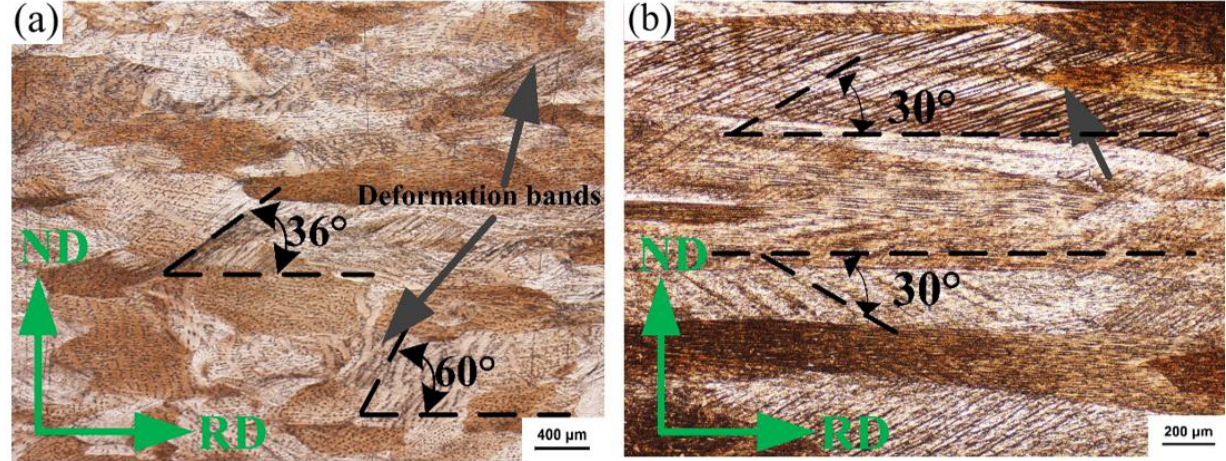
Figure 7. Metallography of longitudinal section of cold rolled strip (ε = 50%). ( a ) EG strip and ( b ) CG strip.